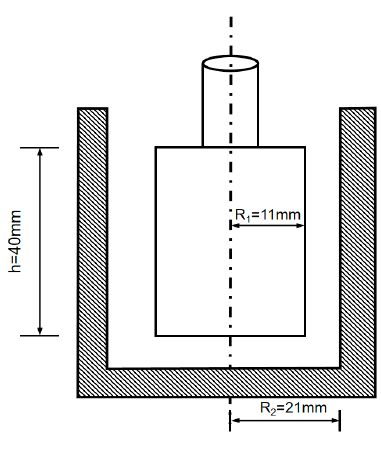
Figure 3. Coaxial cylinder size.